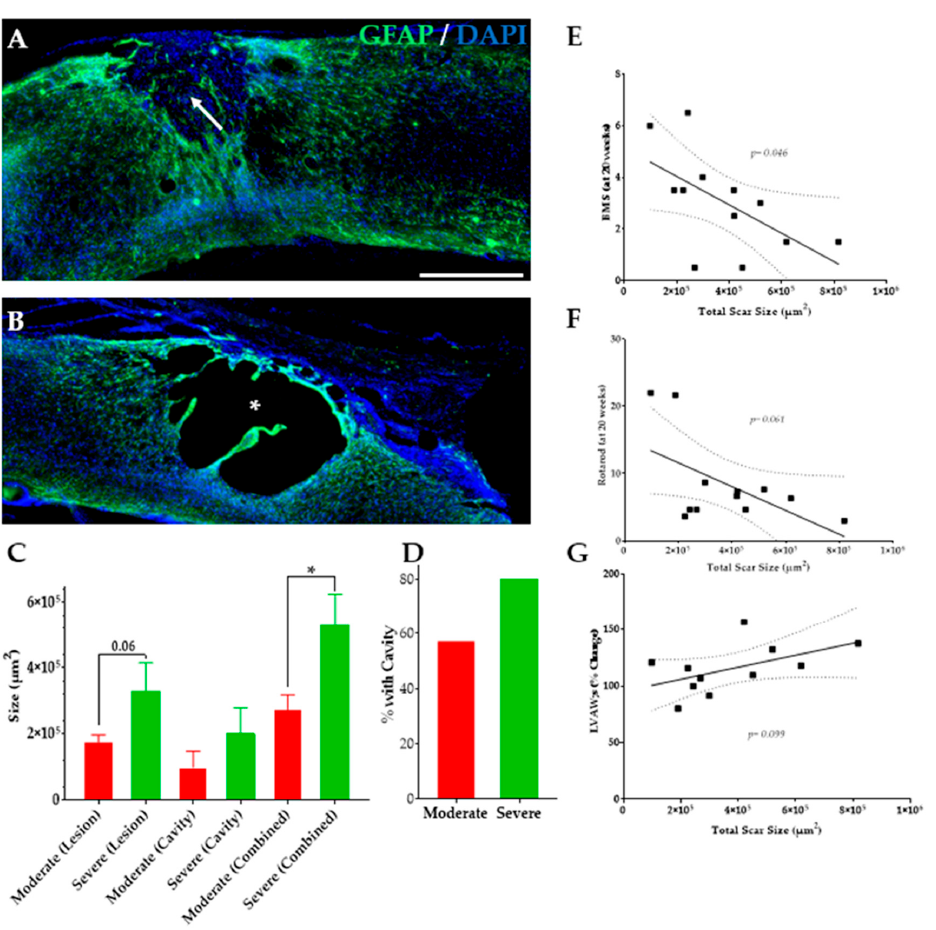
Figure 8. Lesion size and relation to behavior and changes in cardiovascular measures. Sample image of spinal cord (severe group) stained with GFAP (green) and DAPI (blue) showing ( A ) a lesion (white arrow) and ( B ) a cavity (white asterisk) site. ( C ) The average lesion, cavity, and total injury size at 5 months post SCI. ( D ) The percent of mice with cavities at the site of injury. Linear trends of the ( E ) BMS score at 20 weeks PI, ( F ) rotarod performance (time on the rod in seconds) at 20 weeks PI, and ( G ) percent change in LVAW;s in relation to the total injury size of moderate and severe groups. Student’s T-test comparing the means of 2 groups. Linear regression analysis to de- termine correlation between variables. Data presented as means ± SEM, n = 8 (moderate), and 5 (severe). Linear regression trend line ± 95% confidence interval. Scale bar = 500 µm. * p < 0.05. 3.8. SCI and Plasma Cytokines To assess the effects of chronic SCI on cytokine expression, the relative plasma con- centrations of IFN- γ , IL-10, IL-6, TNF- α , and IL-1 β were measured. We observed an